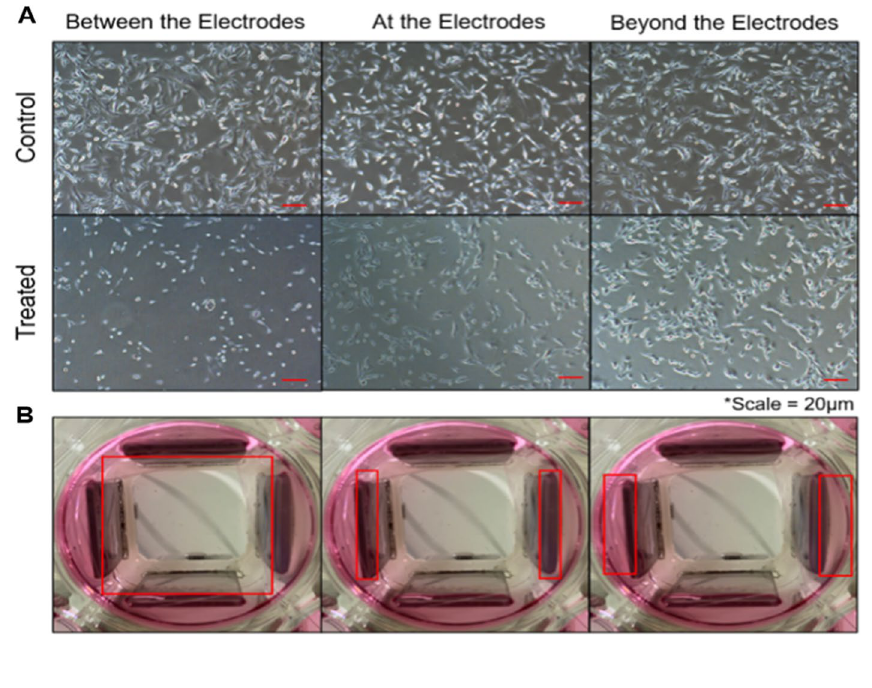
Fig. 5 Effects of TTFields on TNBC cells after 24, 48, and 72 h of TTField treatment at 1.5 V/cm. A, B TNBC cell numbers drop significantly after 24 h of treatment before rebounding to control cell counts at 72 h. ( P < 0.05 =